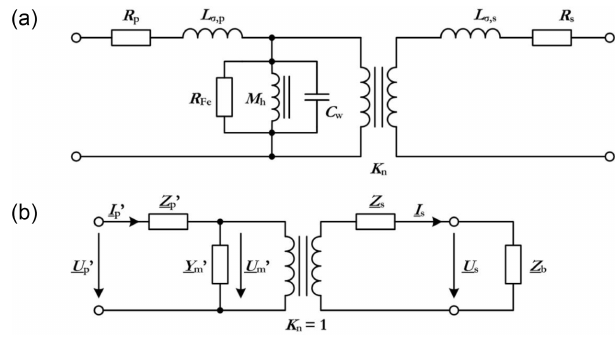
Figure 2. (a) Equivalent circuit of an instrument transformer with discrete components. (b) simplified T -equivalent circuit with primary and secondary longitudinal impedance, transversal impedance, and burden Z b